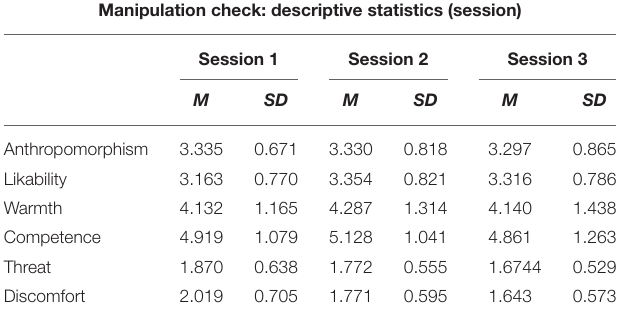
TABLE 2 | Mean ( M ) and standard deviation ( SD ) of the different perceptual dimensions (Q3) per session. Manipulation check: descriptive statistics